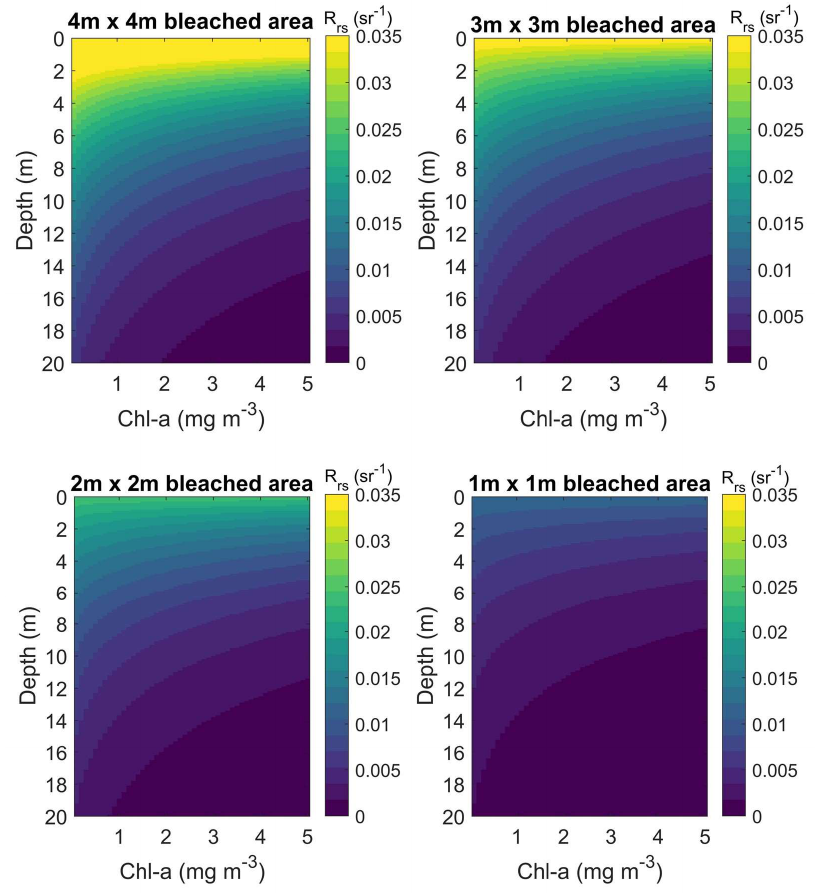
Figure 10. Sensitivity of Dove satellite imaging of sub-pixel bleaching of corals. The 4 m × 4 m panel indicates bleaching across the entire Dove pixel.